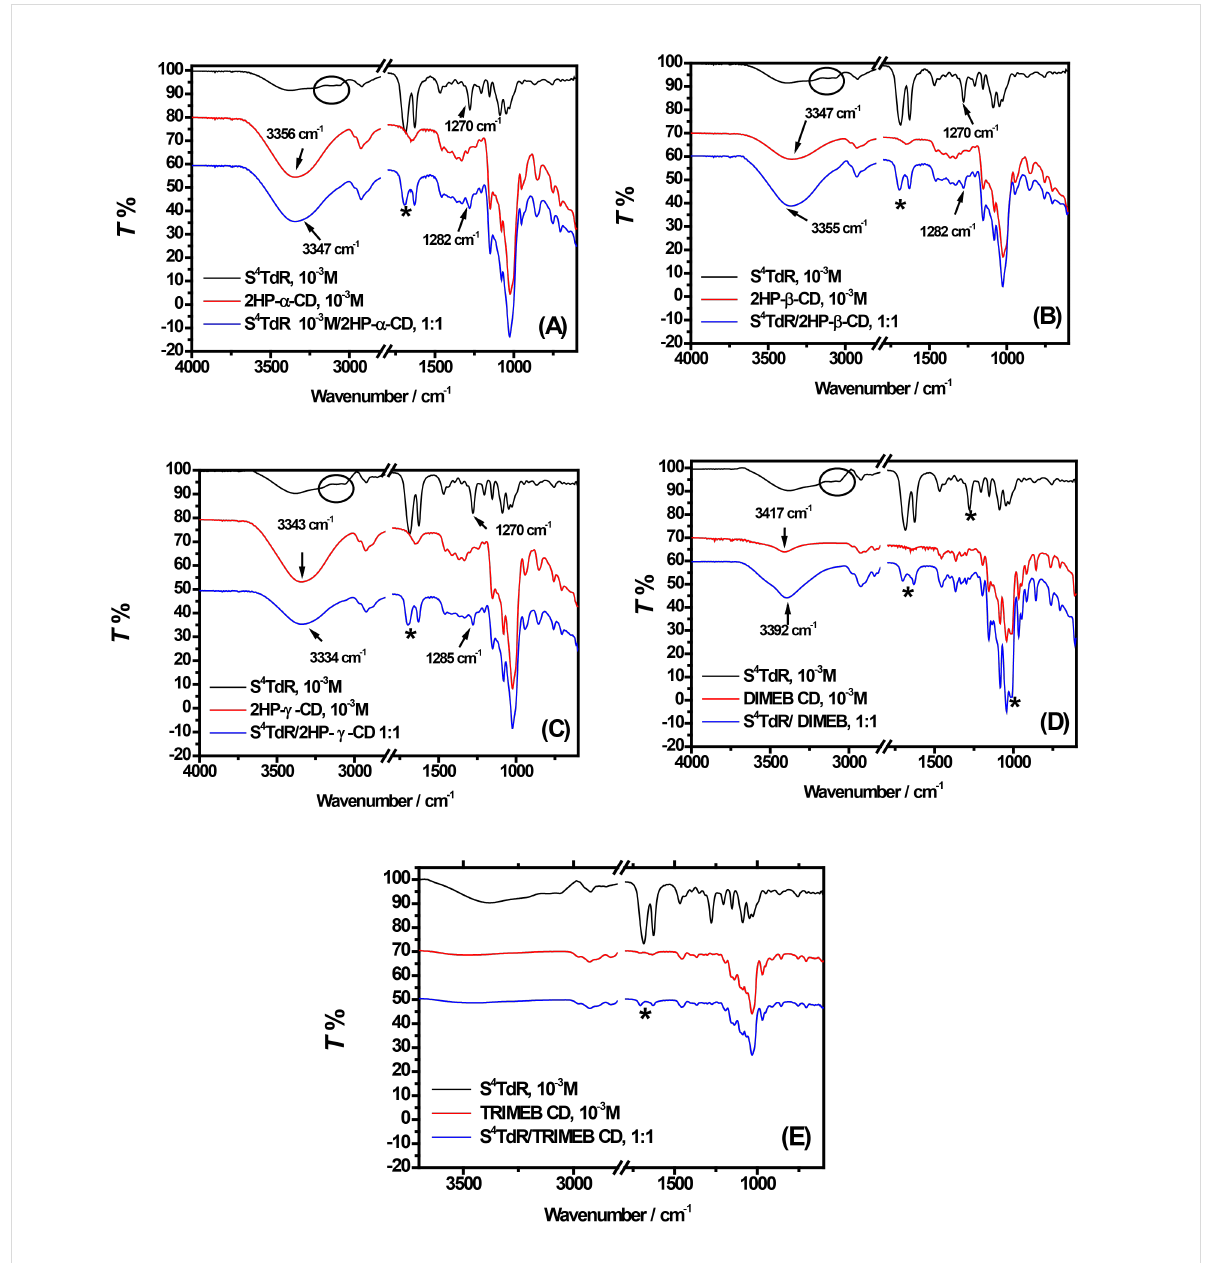
Figure 5: Comparison between detailed views (frequency range: 4000–600 cm − 1 ) of the FTIR–ATR spectra obtained for free S 4 TdR (black lines), free CDs (red lines) and their inclusion complexes (blue lines). (A) 2-HP- α -CD/S 4 TdR, (B) 2-HP- β -CD/S 4 TdR, (C) 2-HP- γ -CD/ S 4 TdR, (D) DIMEB CD/ S 4 TdR, (E) TRIMEB CD/S 4 TdR inclusion complexes. Wavenumbers between 1800 and 2800 cm − 1 are omitted because of the absence of IR bands in this region.